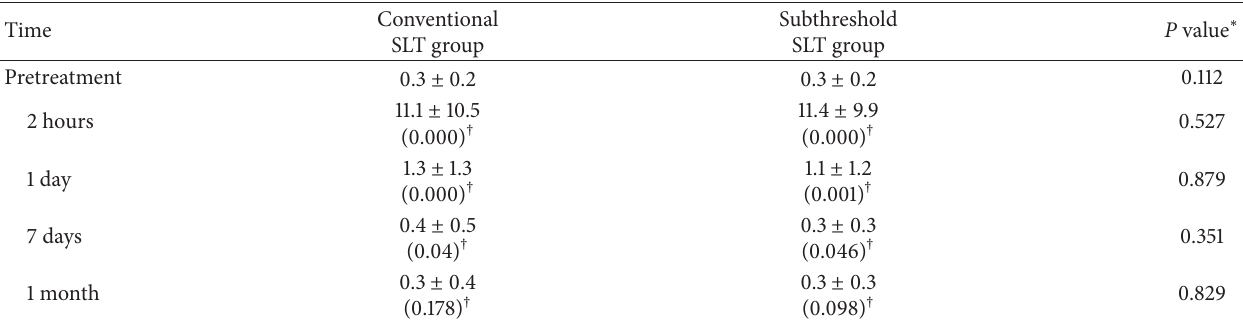
Table 5: Cell density of aqueous humor in conventional SLT group and subthreshold SLT